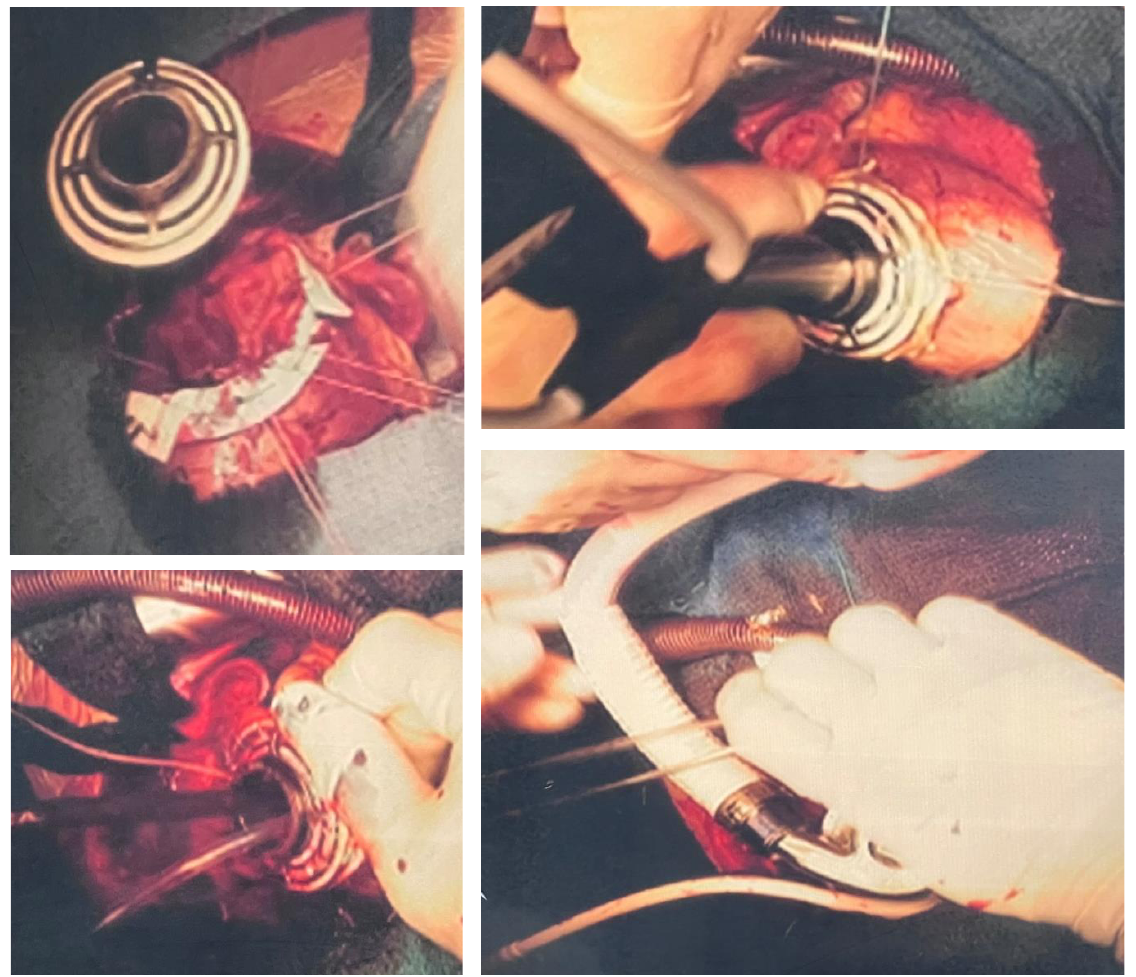
Figure 2 . Steps of inflow